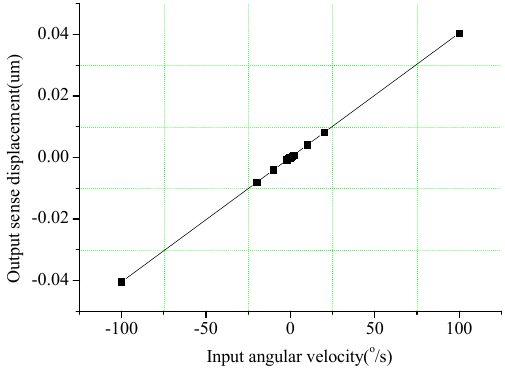
Figure 9. Output sense displacement in the angular velocity input along y -axis.